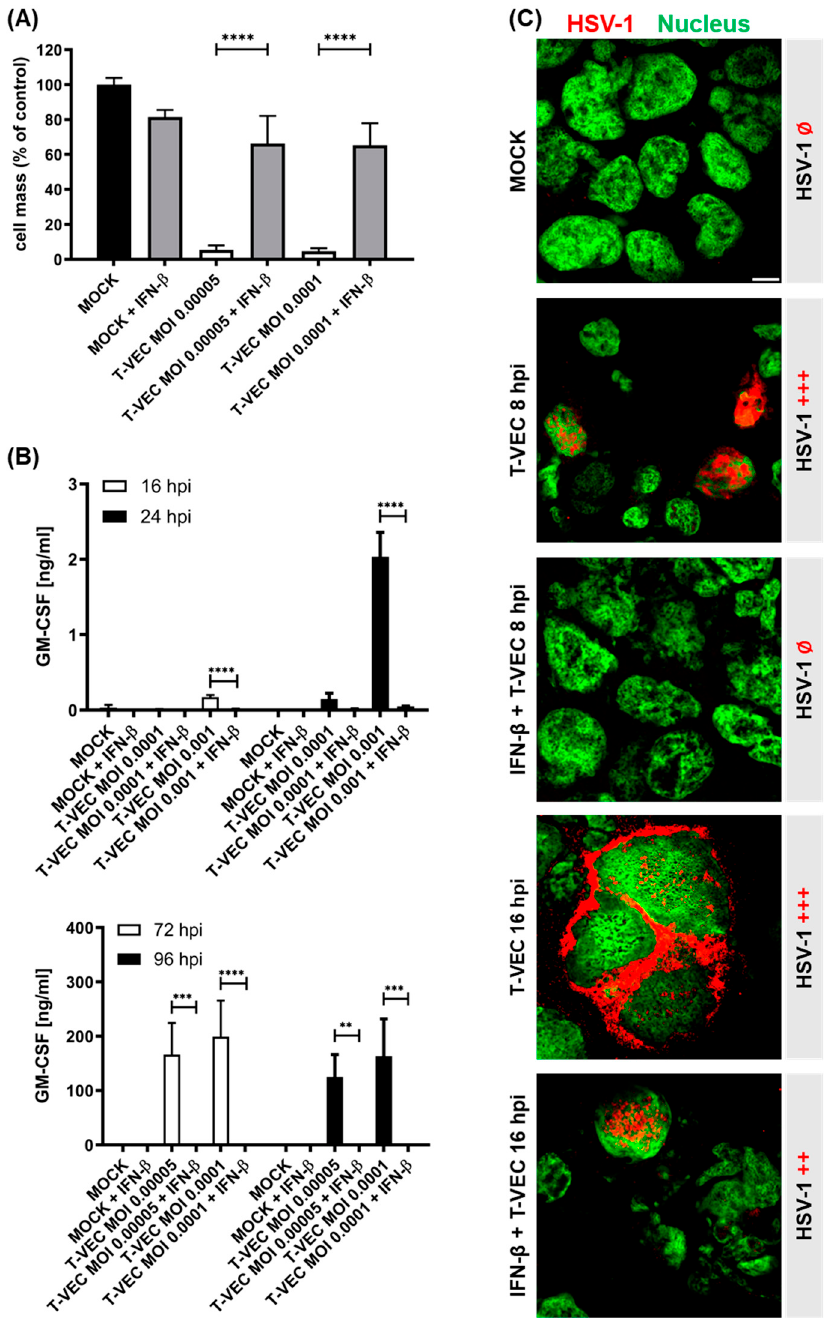
Figure 3. Influence of IFN- β pretreatment on the oncolytic efficacy of T-VEC in 143100 NC cells: ( A ) 143100 NC cells were pretreated with 2 ng/mL IFN- β for 16 h before infection with T-VEC at two different tumor cell line-adjusted multiplicities of infection (MOIs) or remained uninfected (MOCK + IFN- β ). At 96 h post infection (hpi), the remaining tumor cells were determined by SRB viability assays. The anti-tumor effect of each treatment modality was calculated relative to untreated control (MOCK). The mean ± SD of at least two independent experiments performed in triplicates is shown. ** p < 0.01, *** p < 0.001, **** p < 0.0001. ( B ) 143100 NC cells were pretreated with IFN- β analogue to ( A ) and infected with T-VEC at MOIs 0.0001 and 0.001 for the timepoints 16 and 24 hpi and at MOIs 0.00005 and 0.0001 for the timepoints 72 and 96 hpi, respectively. At 16, 24, 72, and 96 hpi superna- tants were harvested and T-VEC-mediated expression of the marker protein GM-CSF was measured via ELISA. ( C ) Immunofluorescence images of 143100 NC cells pretreated with IFN- β and infected with T-VEC (MOI 0.1) for 8 or 16 h. ++, moderate HSV-1 staining; +++, strong HSV-1 staining; Ø, no HSV-1 staining. Scale bar shows 5 µm.